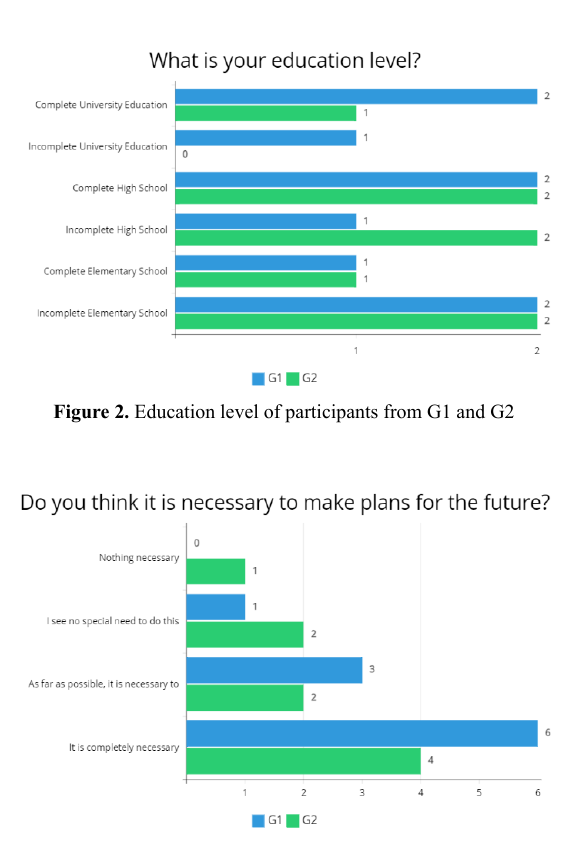
Figure 3. The importance of planning for the future of G1 and